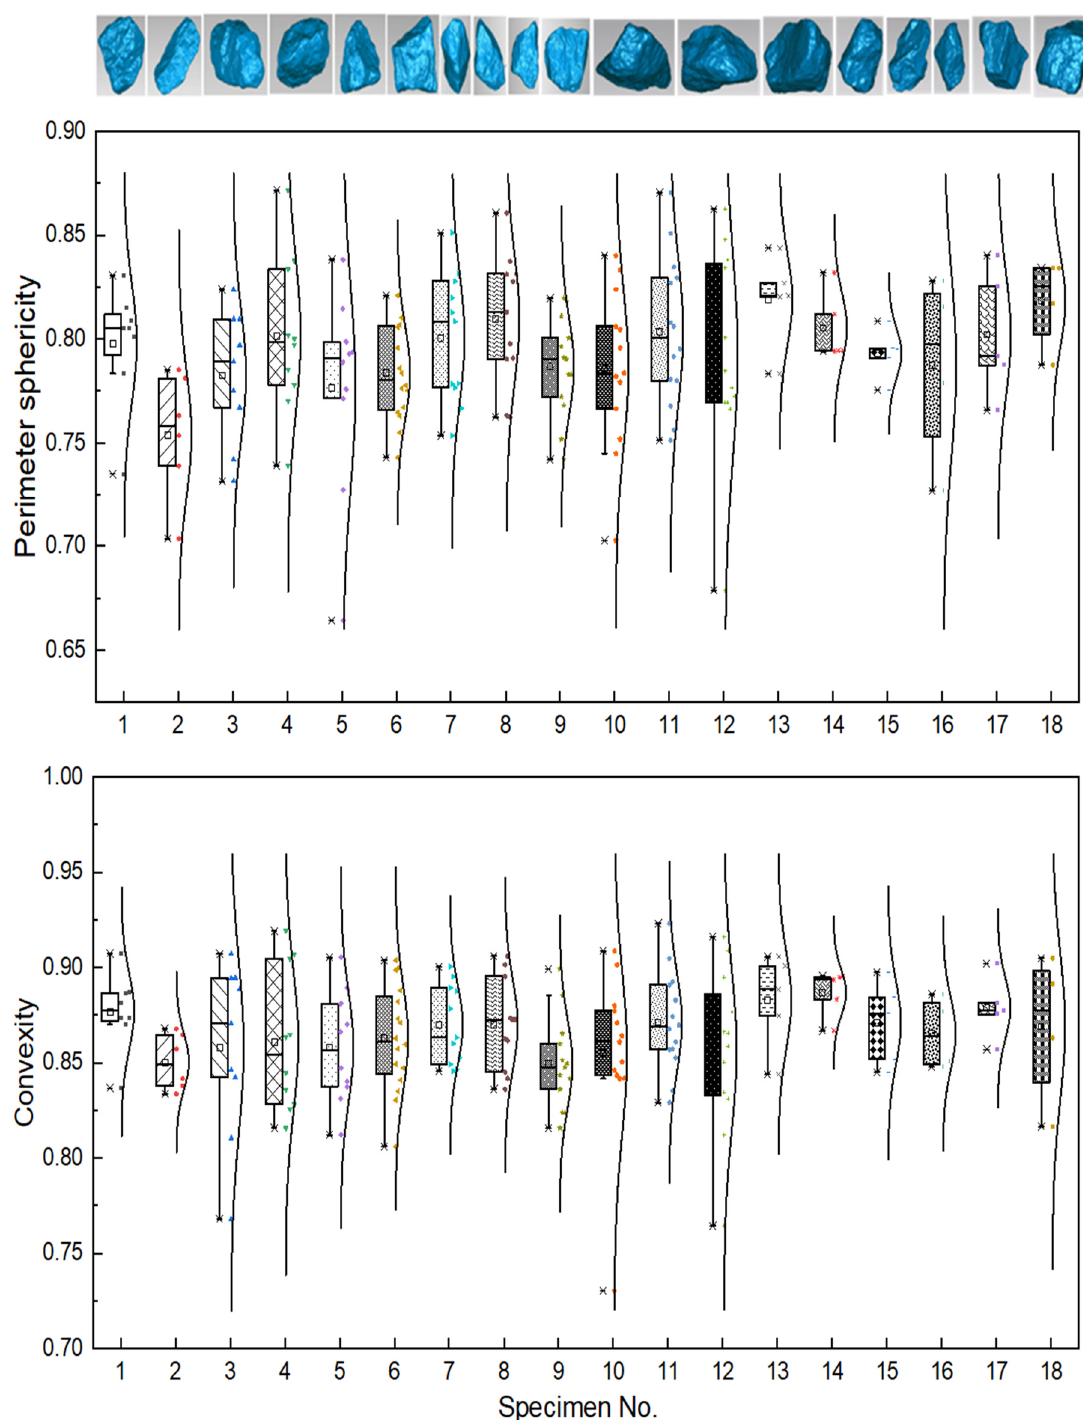
Figure 7. The visual and quantitative comparisons of particle perimeter sphericity and convexity values for all the gyratory specimens tested.